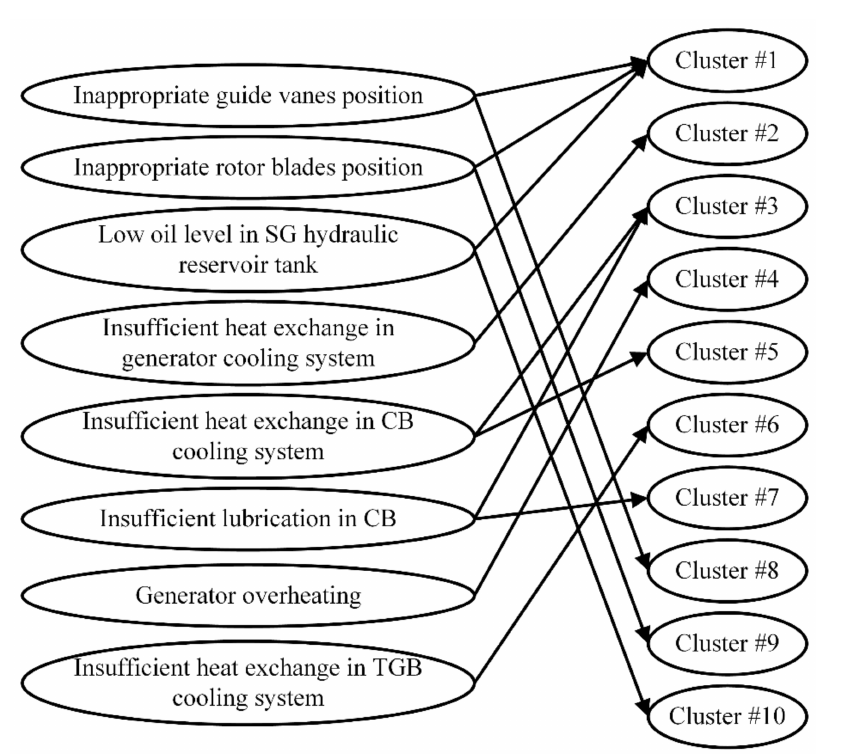
Figure 7. Detection results over time.